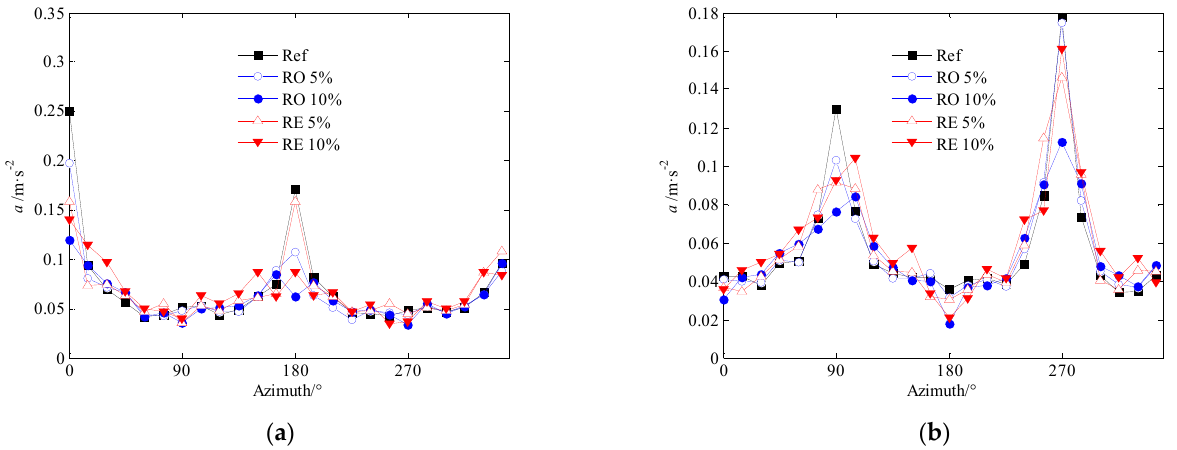
Figure 6. Standard deviations of accelerations in different azimuths: ( a ) x -direction. ( b ) y -direction.